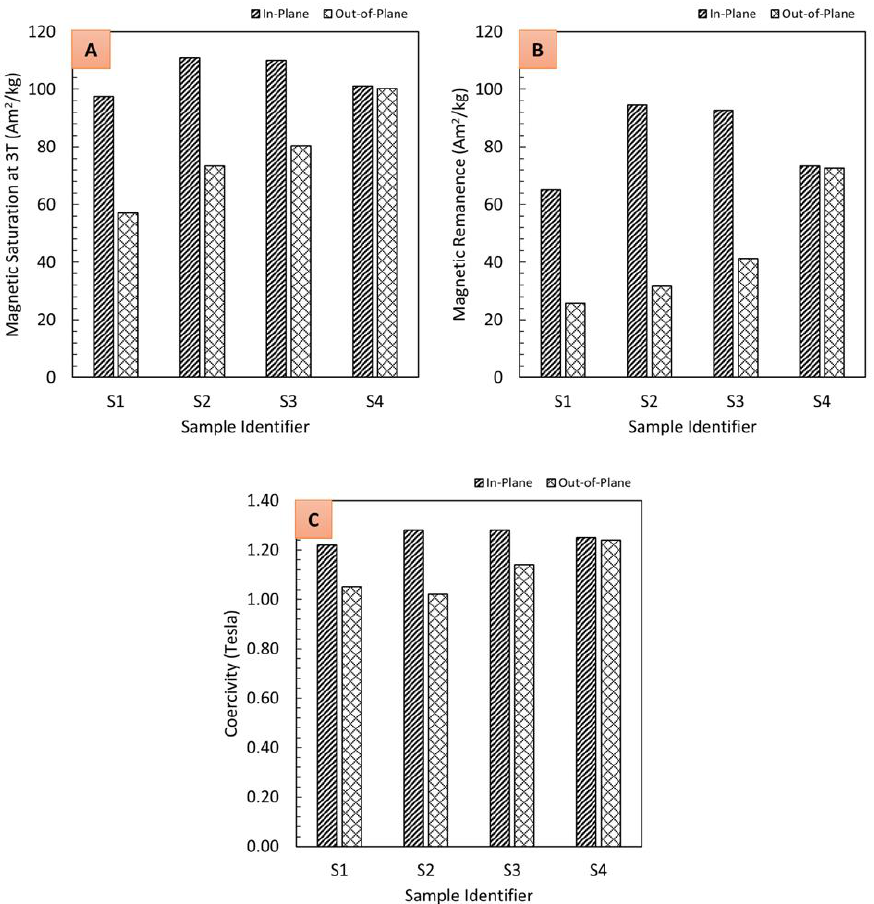
Figure 14. In-plane and out-of-plane magnetic properties of composites as listed in Table 1, de- rived considering magnetization and demagnetization cycles of hysteresis data: ( A ) magnetic satu- ration at 3 Tesla, ( B ) remanence, and ( C ) coercivity.